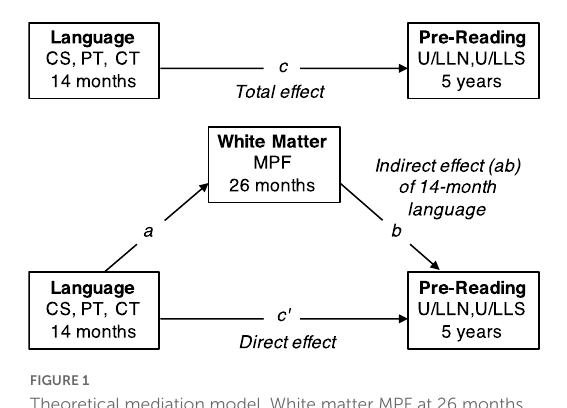
FIGURE1 Theoretical mediation model. White matter MPF at 26 months was tested as a hypothetical mediator of the relationship between 14-month language measures [child speech (CS), parentese (PT), and conversational turns (CT)] and 5-year pre-reading skills [upper and lowercase letter name (U/LLN), and upper and lowercase letter sound (U/LLS),